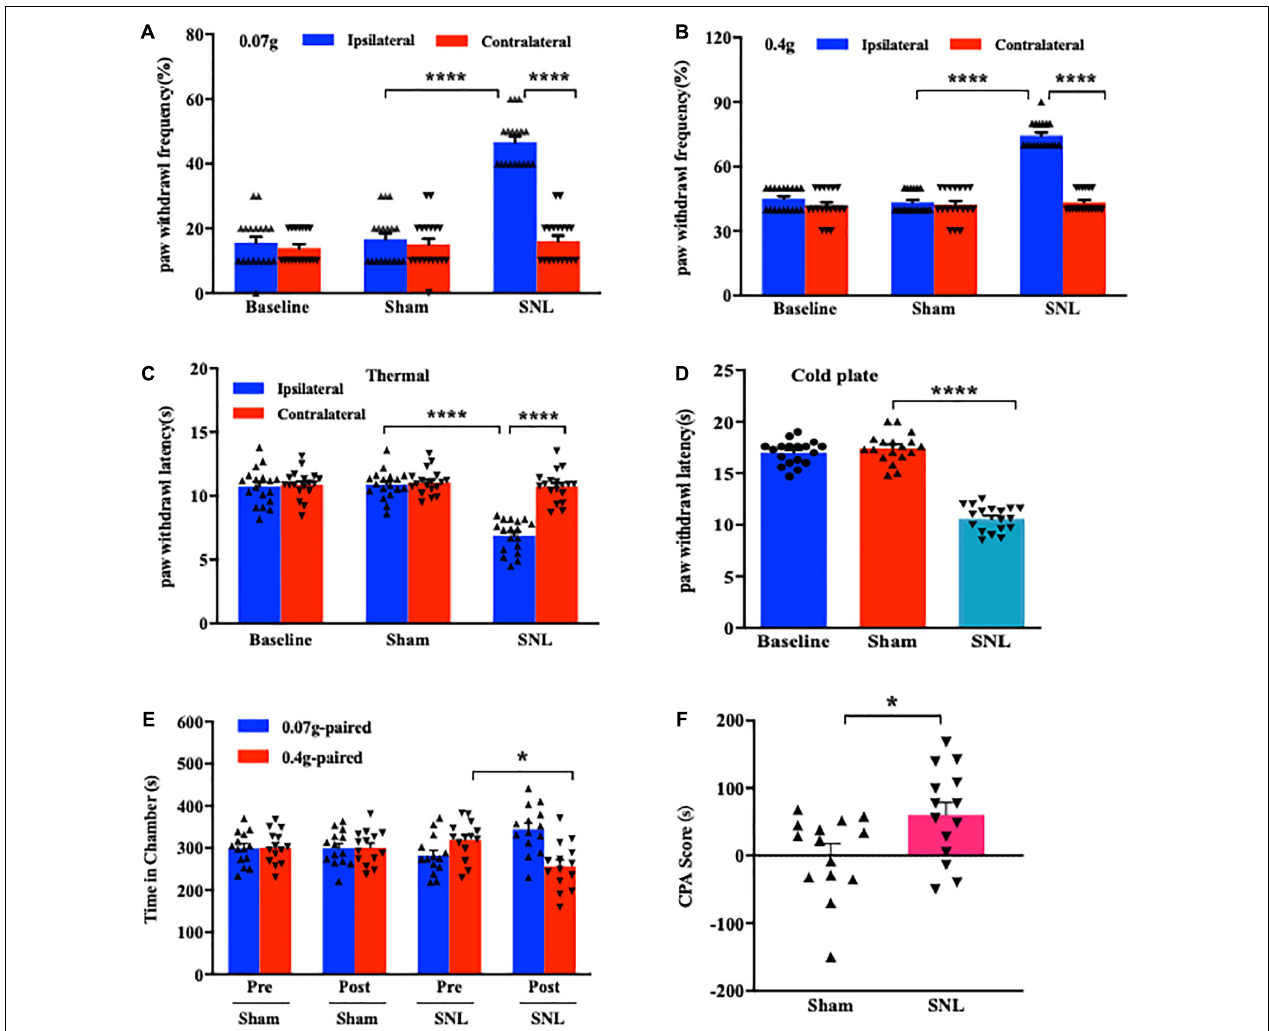
FIGURE 1 | Unilateral L4 spinal nerve ligation (SNL) produced nociceptive hypersensitivities and pain aversiveness in mice. (A,B) Paw withdrawal frequencies in response to 0.07 g (A) and 0.4 g (B) von Frey filament stimuli on the ipsilateral and contralateral sides on day 7 following SNL or Sham surgery. n = 18/group. **** P < 0.0001 versus the corresponding sham group or the corresponding contralateral side by two-way ANOVA with repeated measures followed by post hoc Tukey test. (C,D) Paw withdrawal latencies in response to thermal (C) and cold (D) stimuli on the ipsilateral and contralateral sides on day 7 post-SNL or -Sham surgery. n = 18 mice/group for thermal test and 14 mice/group for the cold test. **** P < 0.0001 versus the corresponding sham group or the corresponding contralateral side by one-way (D) or two-way (C) ANOVA with repeated measures followed by post hoc Tukey test. (E,F) Time spent in the corresponding chamber paired with 0.07 g or 0.4 g von Frey filament stimuli (E) and CPA score (F) in the sham-operated and SNL-operated groups. n = 14 mice/group. Pre: Precondition. Post: Postcondition. N.S: not significant, P > 0.99. * P < 0.05 versus the corresponding precondition (E) or sham group (F) by two-way ANOVA with